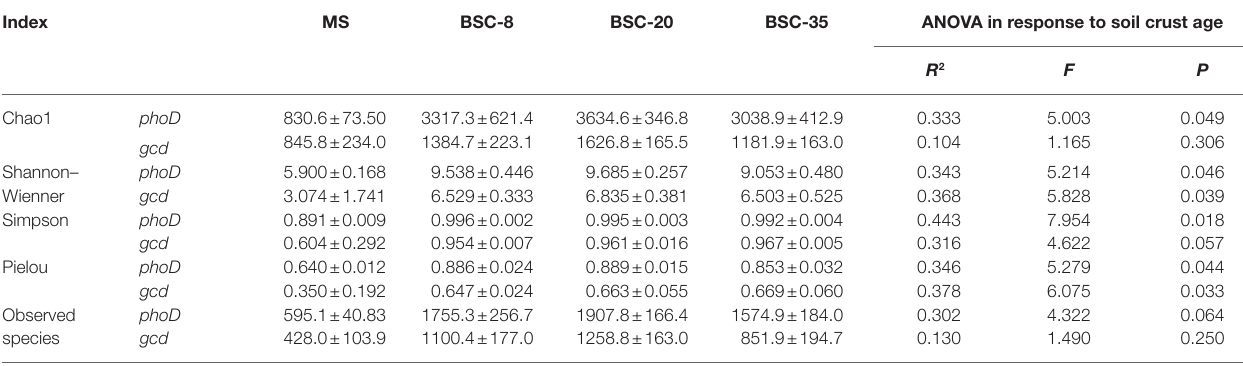
TABLE 4 | Diversity indices of phoD and gcd microbial communities in an age sequence of soil crusts.